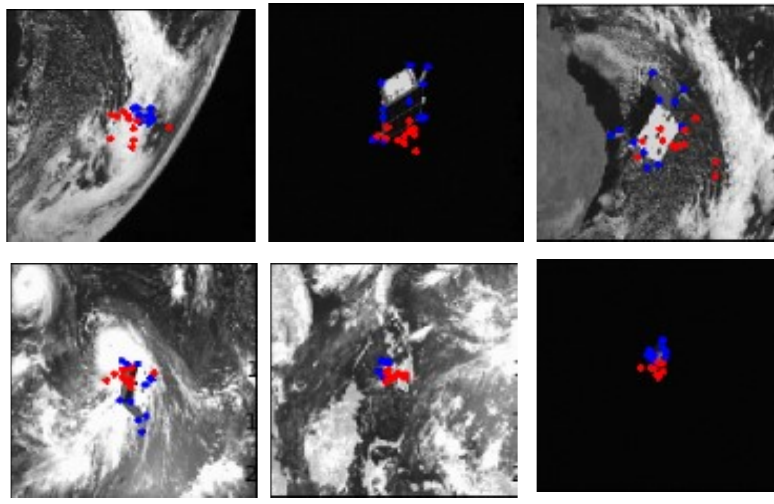
Figure 5. Direct Regression Performance after 40 Epochs